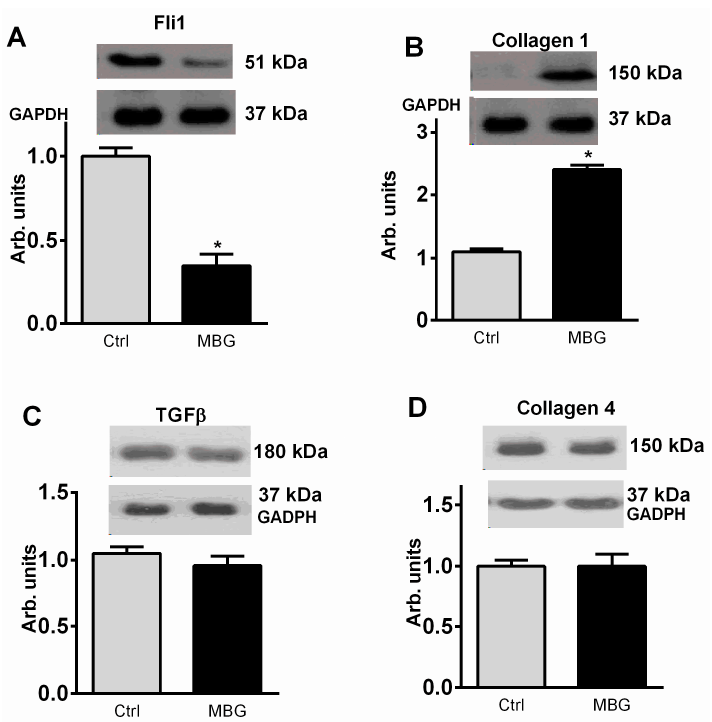
Figure 5. Levels of Fli1 ( A ), collagen-1 ( B ), TGF β ( C ) and collagen 4 ( D ) by. Western blotting in the umbilical arteries from subjects with uncomplicated pregnancy nontreated (Ctrl) and treated by 10& M MBG. Top panels, Western blotting representative bands; bottom panels, GAPDH for statistical analysis. Each bar represents individual samples pooled and averaged to give means and SEM of 5 measurements. By one-way ANOVA followed by Bonferroni test: * p < 0.01 vs. Ctrl.